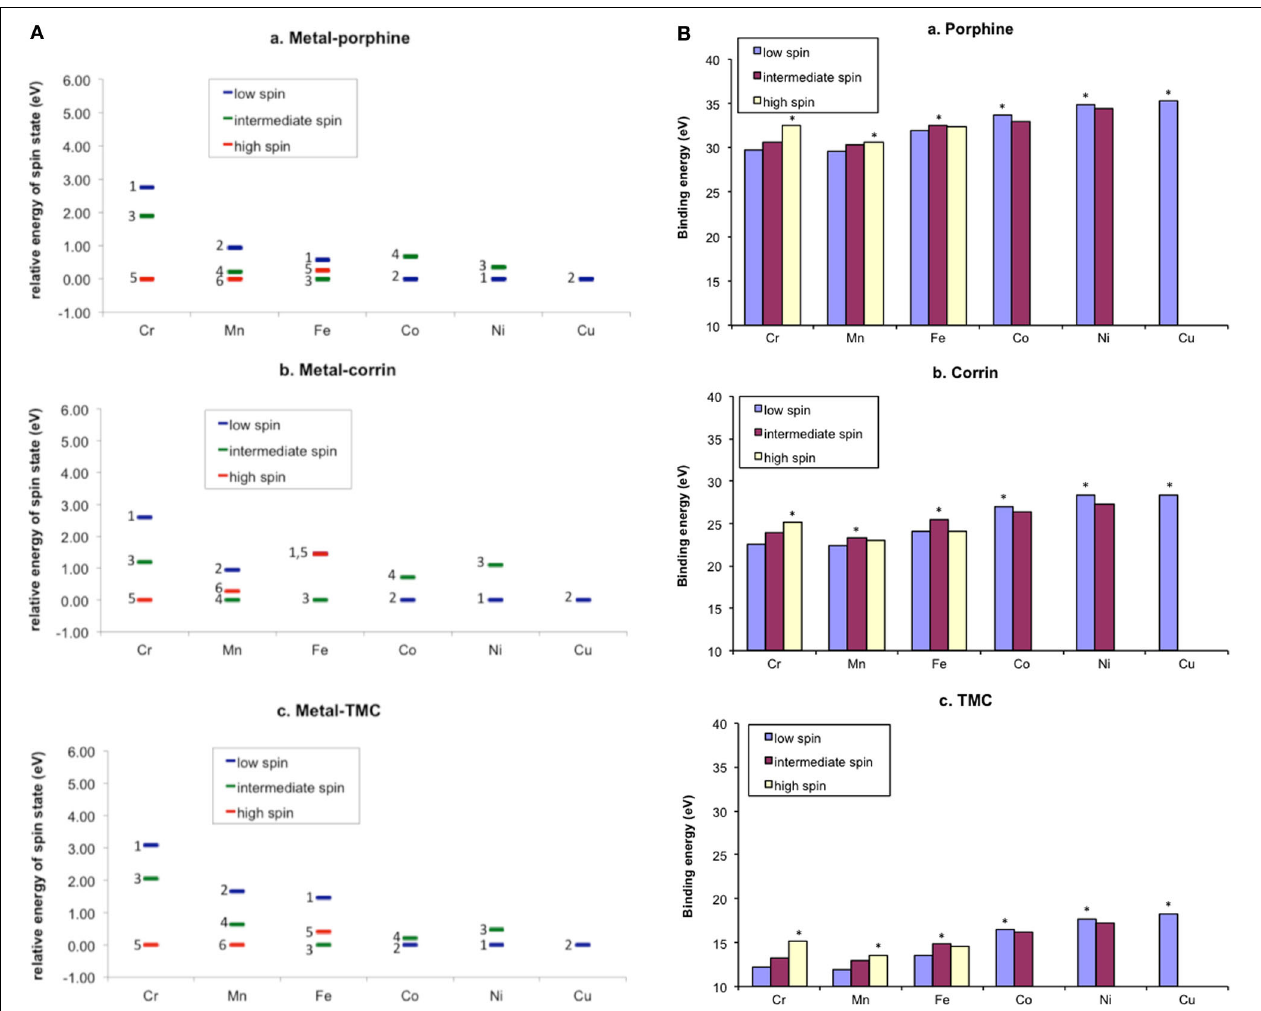
FIGURE 3 | (A) Relative stability of various complexes metal(II)-ligand complexes in different spin states. (B) Binding energy of the complexes. Adapted from Myradalyyev et al. (2013) with permission from